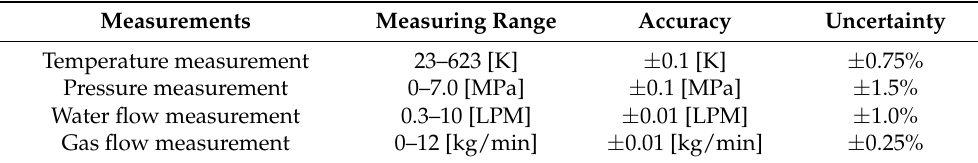
Figure 5. Schematic diagram of the experimental setup for cold water supply using liquid nitrogen as a cold energy source. Table 2. List of measurements, measuring range, accuracy, and uncertainty.